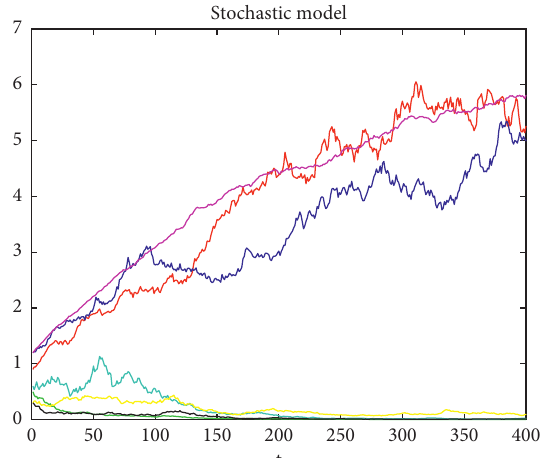
Figure 4: The red line, blue line, and magenta line represent S and S H , respectively; the green line, cyan line, yellow line, and black line represent I D ,I L ,E H , and I H ,